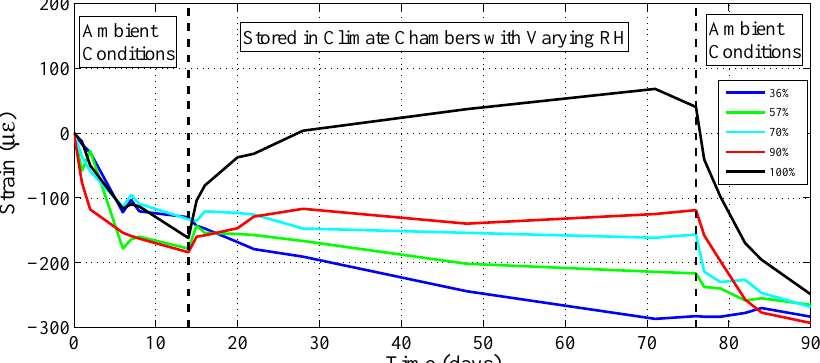
Figure 13. Strain evolution of unstrengthened blocks during: (i) two weeks of storage in the lab environment; (ii) exposure to constant temperature (20 ◦ C) and a variety of constant RH ranging from 36–100%; (iii) two weeks of storage in the lab